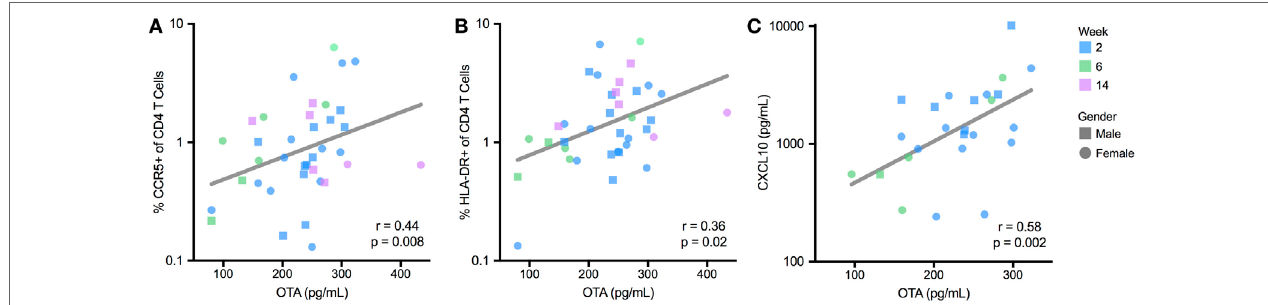
FigUre 4 | Plasma ochratoxin A (OTA) correlates with markers of immune activation in BCG-unvaccinated, non-breastfed infants. T cell activation, reported as a percentage of CCR5 (a) and HLADR-expressing CD4 T cells (b) , was quantified by flow cytometry, and plasma CXCL10 levels (c) were quantified by multiplex immunoassay. R and p -value reflect Spearman correlation. For (a–c) , lines reflect the best-fit, univariate, linear correlation. CXCL10 levels were not quantified for 8-week-old infants. All infants were HIV-exposed.